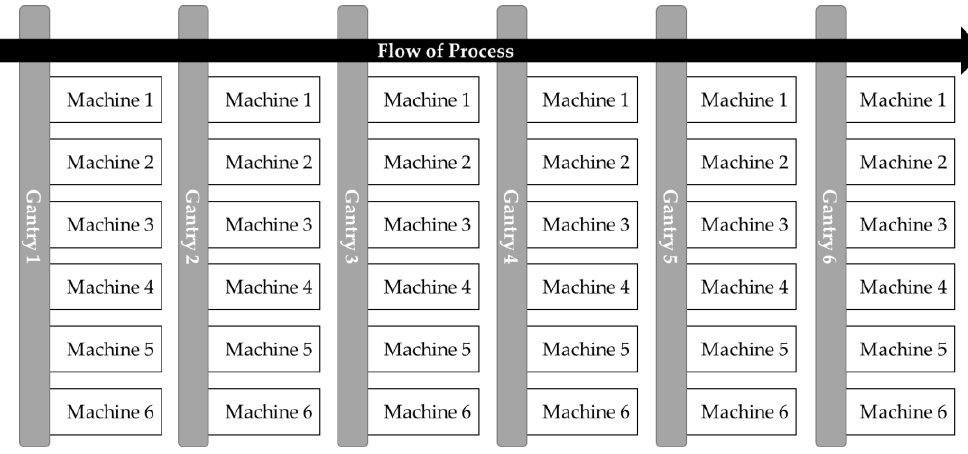
Figure 5. An example of a gantry type system.